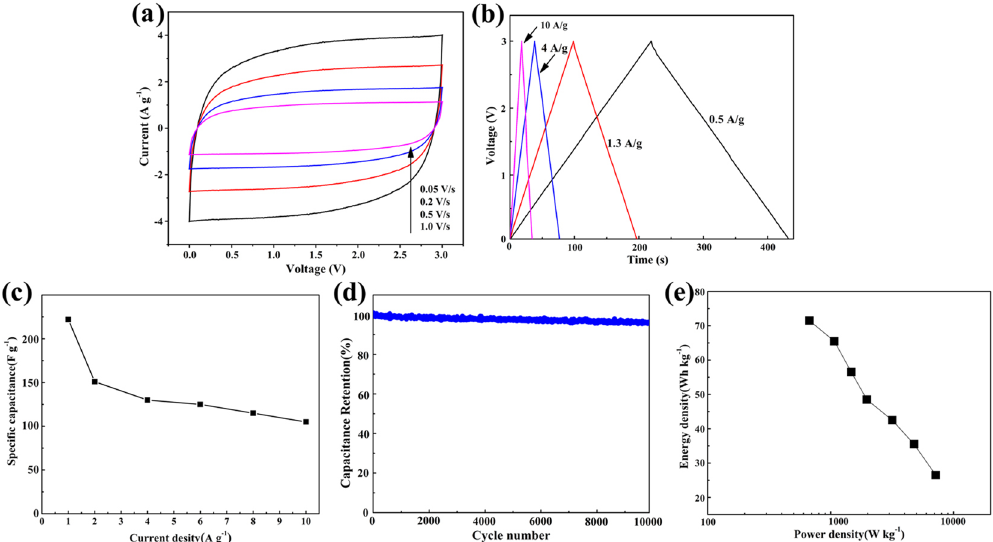
Figure 4. Electrochemical performances of the CNTs/GNFs in an organic electrolyte (NaClO 4 in EC/DMC). ( a ) CV curves at scan rates from 0.05 to 1 mV s −1 . ( b ) GCD curves under various current densities. ( c ) The specific capacitance of CNTs/GNFs calculated at various current densities. ( d ) Cycling stability tests at 2 A g −1 . ( e ) The Ragone plots of